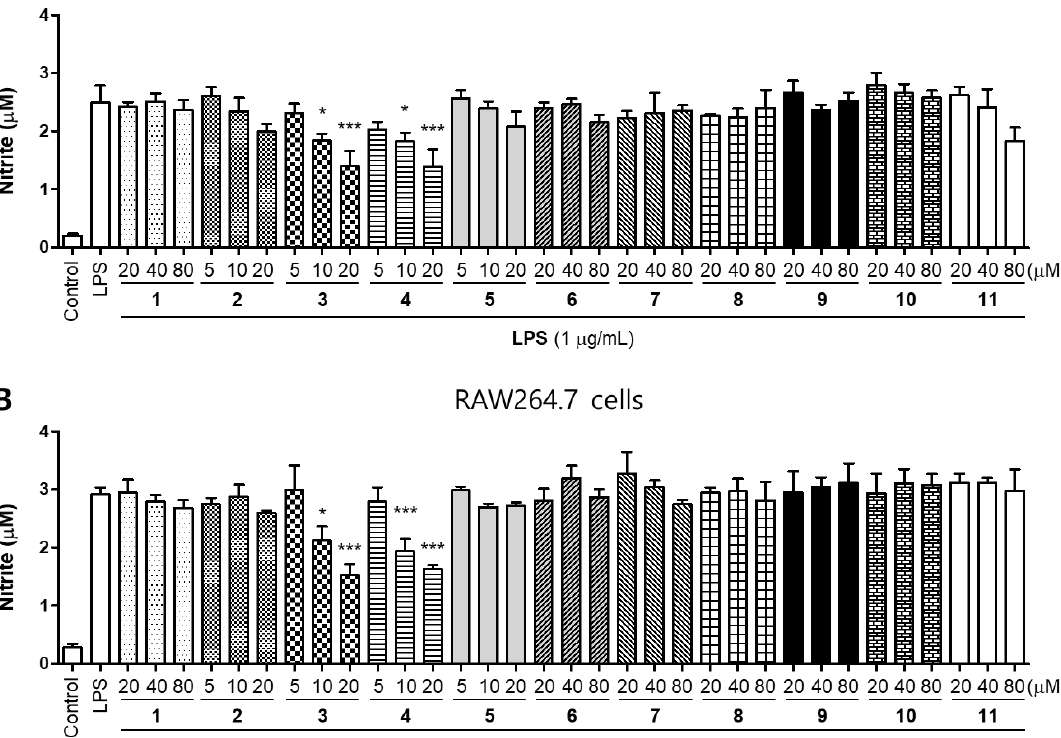
Figure 3. Inhibitory effects of compounds 1 – 11 on nitrite production in BV2 ( A ) and RAW264.7 ( B ) cells. The cells were pretreated for 2 h with concentrations of compounds and stimulated for 24 h with lipopolysaccharide (LPS; 1 µ g/mL). Error bars represent mean ± standard deviation of three independent experiments. * p < 0.05 and *** p < 0.001 compared with the LPS-treated